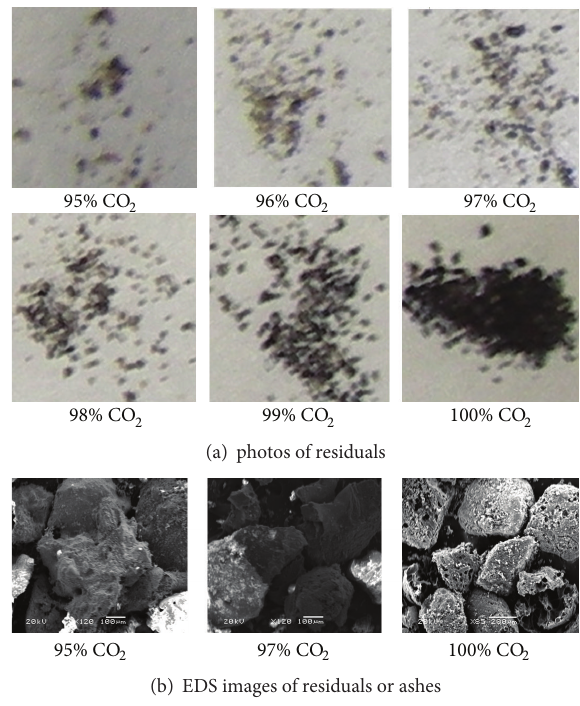
Figure 12: Photos of residuals at various CO 2 concentrations with a temperature of 1400 ∘ C.